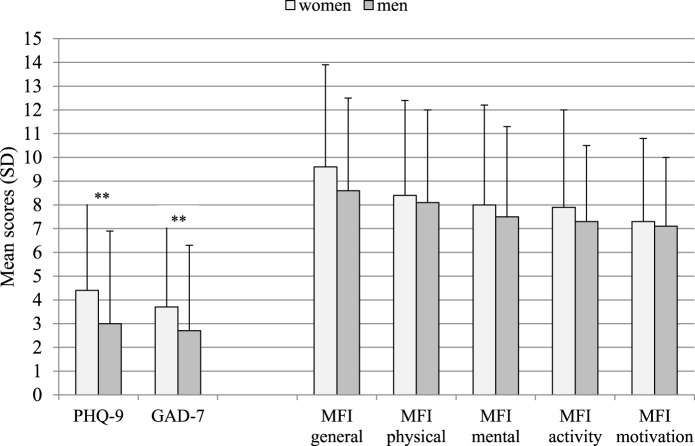
Mean scores and SDs on the Patient Health Questionnaire-Depression Scale (PHQ-9), GAD-7, and Multidimensional Fatigue Inventory subscales by sex. **Mann–Whitney U-test: p ≤ 0.001. PHQ-9, Depression subscale of the Patient Health Questionnaire; GAD-7, Generalized Anxiety Subscale of the Patient Health Questionnaire; MFI, Multidimensional Fatigue Inventory-20.